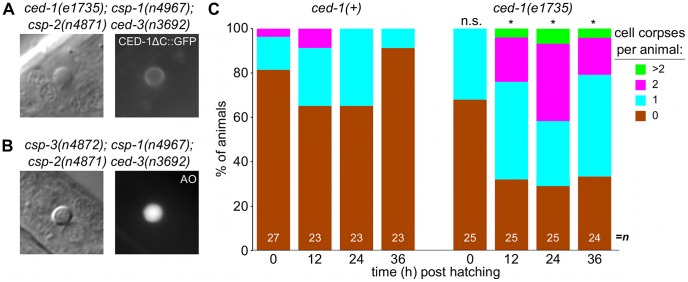
Caspase-independent cell corpses are engulfed and degraded.(A) Nomarski DIC and fluorescence images of a cell corpse from a ced-1(e1735); csp-1(n4967); csp-2(n4871) ced-3(n3692) L1 larva carrying the integrated transgene nIs400[Pced-1::ced-1ΔC::gfp], which expresses a non-rescuing CED-1ΔC::GFP fusion protein. CED-1 is a transmembrane receptor that is expressed on engulfing cells, binds to apoptotic cell corpses, and is required for phagocytosis [46]. (B) Nomarski DIC and fluorescence images of a cell corpse from a csp-3(n4872); csp-1(n4967); csp-2(n4871) ced-3(n3692) L1 larva stained with acridine orange (AO), which fluoresces in engulfed cell corpses undergoing degradation in endosomal compartments. (C) The fraction of csp-1(n4967); csp-2(n4871) ced-3(n3692) and ced-1(e1735); csp-1(n4967); csp-2(n4871) ced-3(n3692) with 0, 1, 2 or >2 cell corpses at different time points post hatching. Asterisks indicate p<0.05 in a Mann-Whitney test comparing the two genotypes at a given time point.